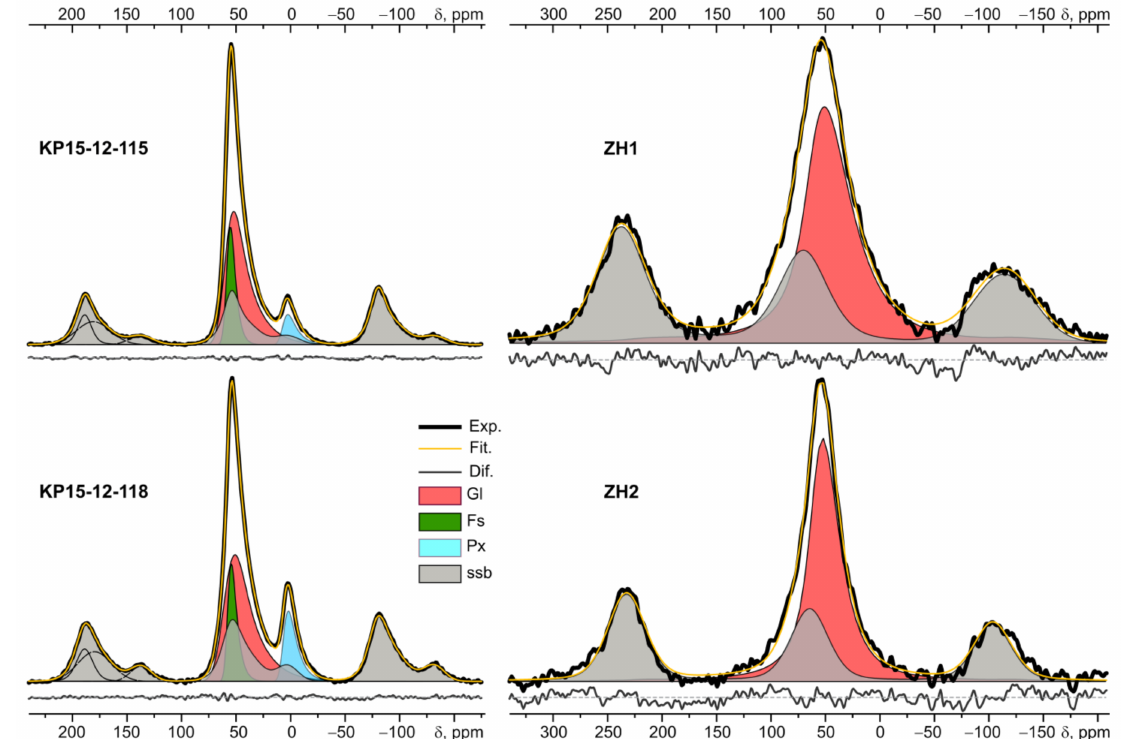
Figure 6. Deconvolution of the central band of the 27 Al MAS NMR spectra: Exp.—experimental spectra; Fit.—full deconvolution spectra; Dif.—difference (Exp.—Fit.); Gl, Fs, and Px are Czjzek components; ssb—spinning sidebands approximated by the superposition of Voigt line shapes (three components for the Kara glass samples, and one component for zhamanshinites). For the fitting of ZH1 and ZH2 spectra, the ssb components of the central transition ( ± 1/2, ± 1/2) were included in the Czjzek